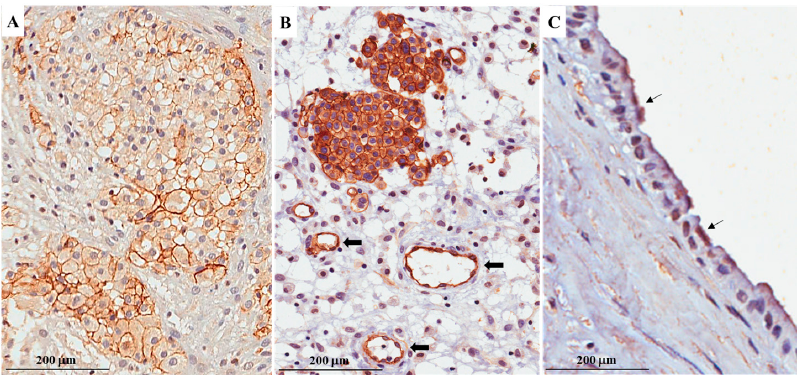
Figure 2. ( A ) Linear and circumferential membranous staining for aquaporin-1 (AQP1) is depicted; ( B ) Vascular endothelial cells were used as positive control for AQP1 immunostain (arrows); ( C ) For comparison, the AQP1 immunohistochemical stain on non-neoplastic mesothelium is shown; in detail, the immunostain was exclusively localized to the apical cellular portion of mesothelial cells (arrows).